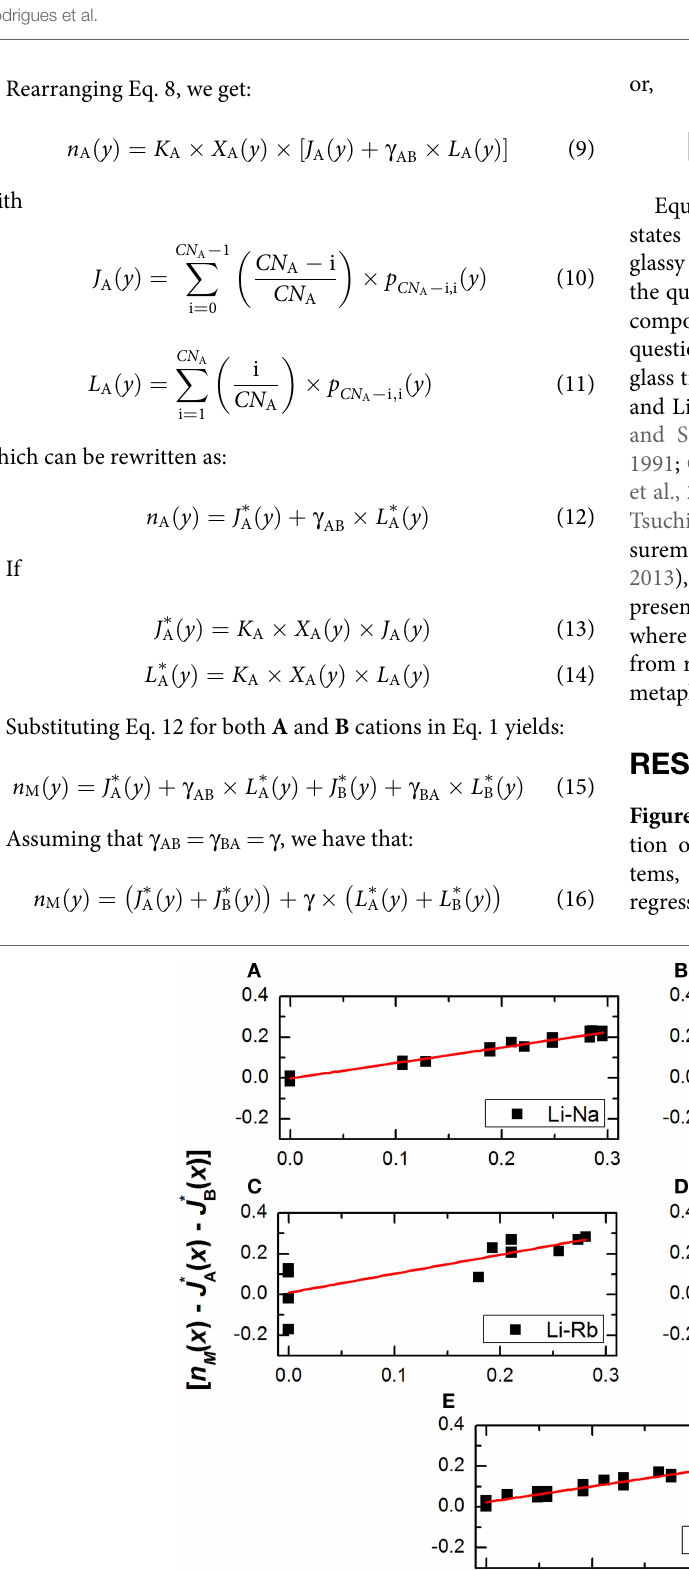
Fr ontiers in Materials |